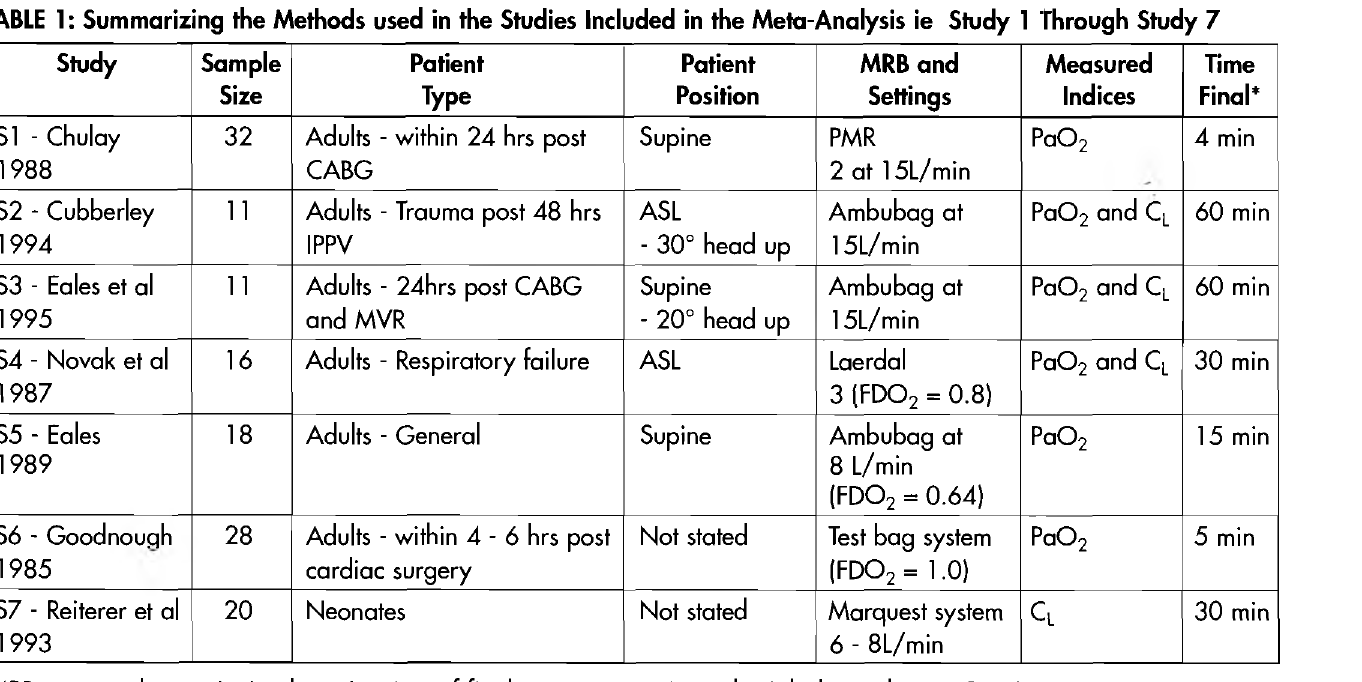
TABLE 1: Summarizing the Methods used in the Studies Included in the Meta-Analysis ie Study 1 Through Study 7 Study